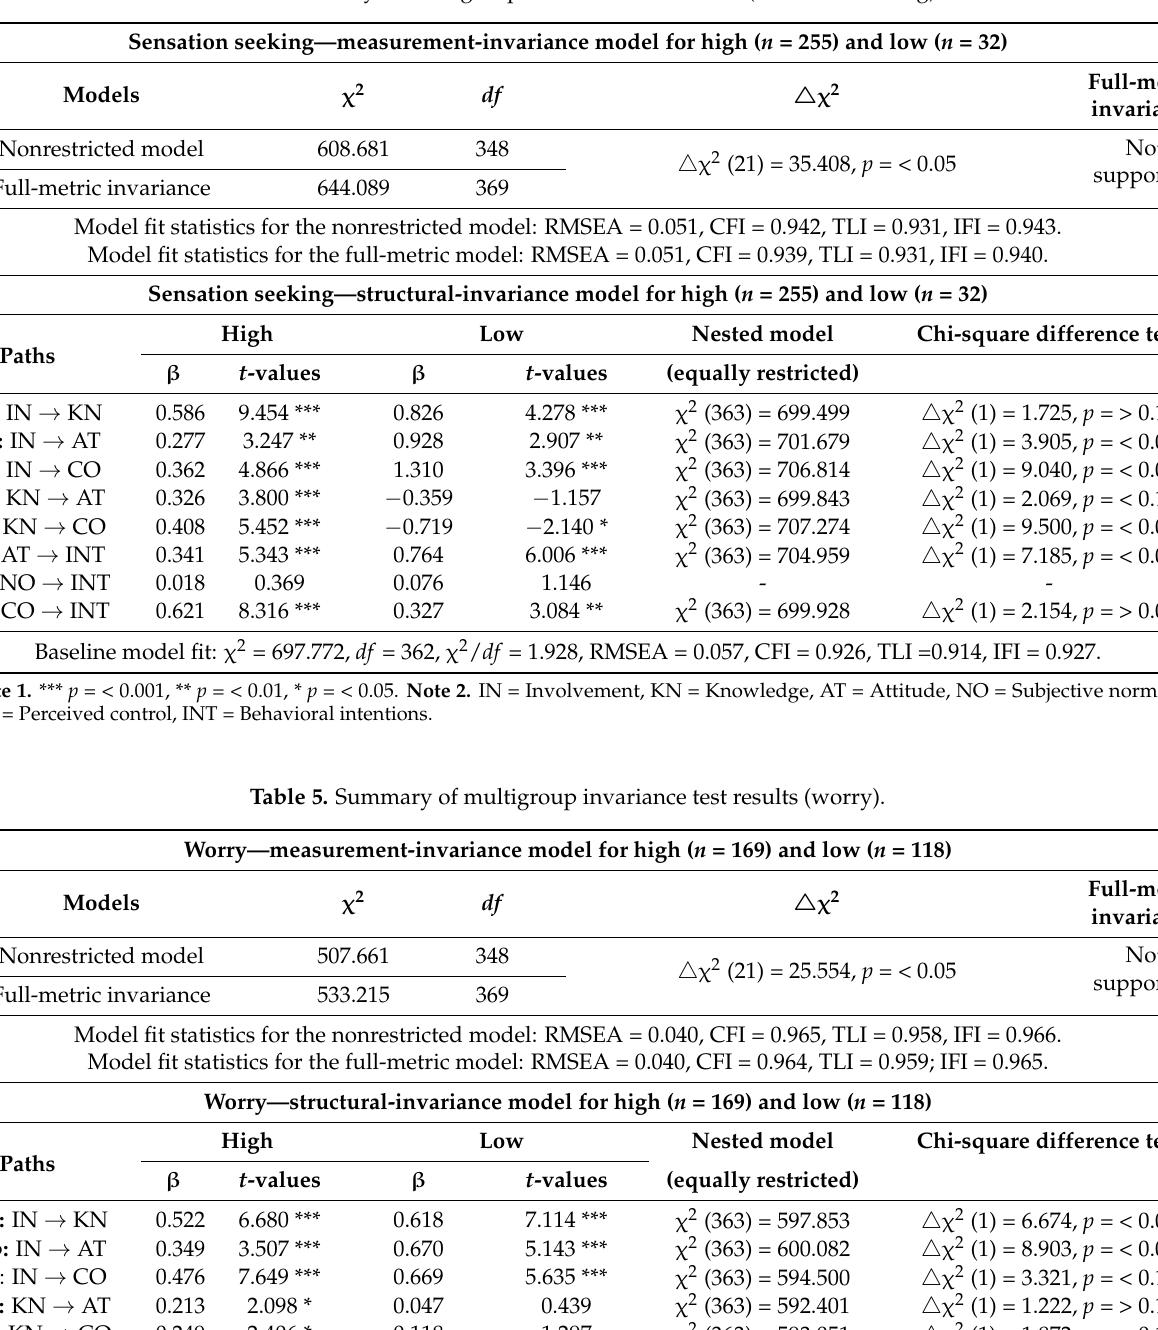
Table 4. Summary of multigroup invariance test results (sensation seeking).